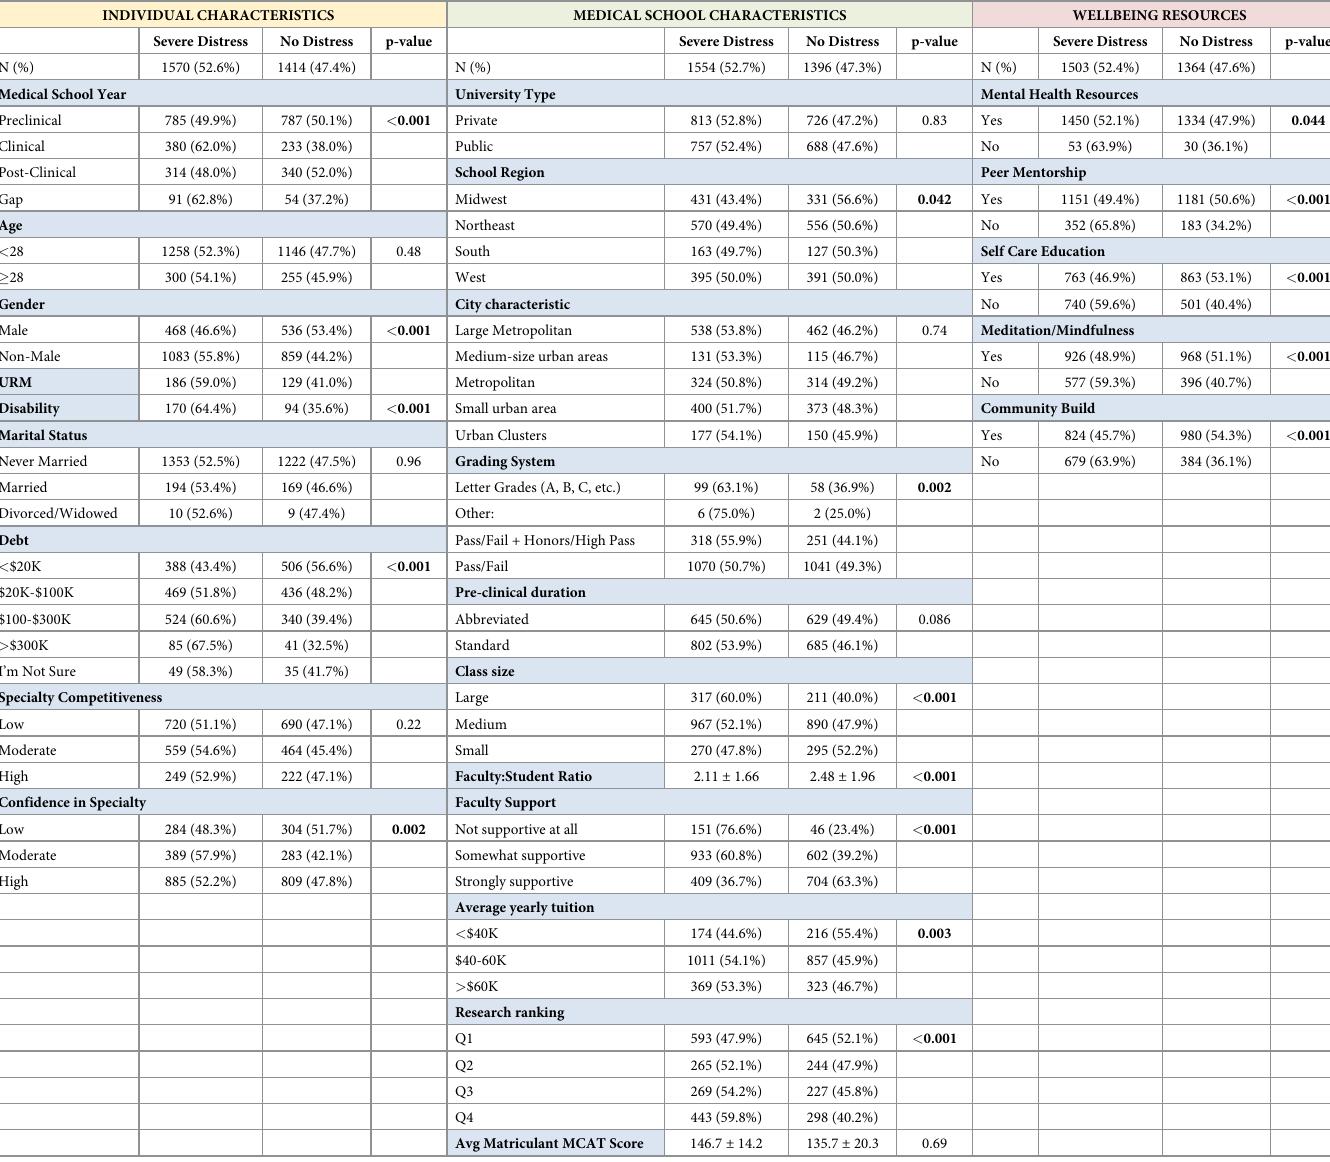
Table 1. Impact of medical student and medical school characteristics on student distress (univariate model).